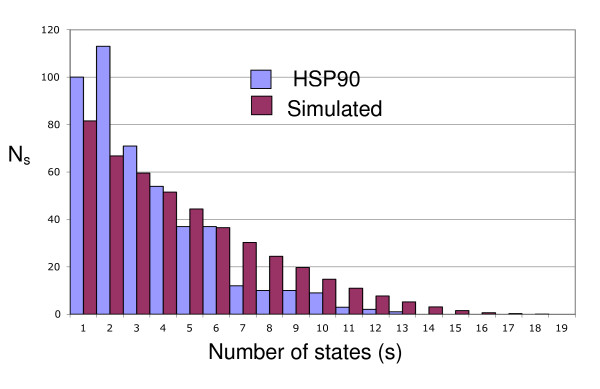
Numbers of sites with a given number of states in simulated versus real HSP90 data. The original HSP90 data have 54 taxa and 459 sites. The simulated data have the same number of taxa and 100,000 sites. In the latter case the proportions of sites with each number of states were calculated and then multiplied by 459 to make the numbers directly comparable to the HSP90 data set.